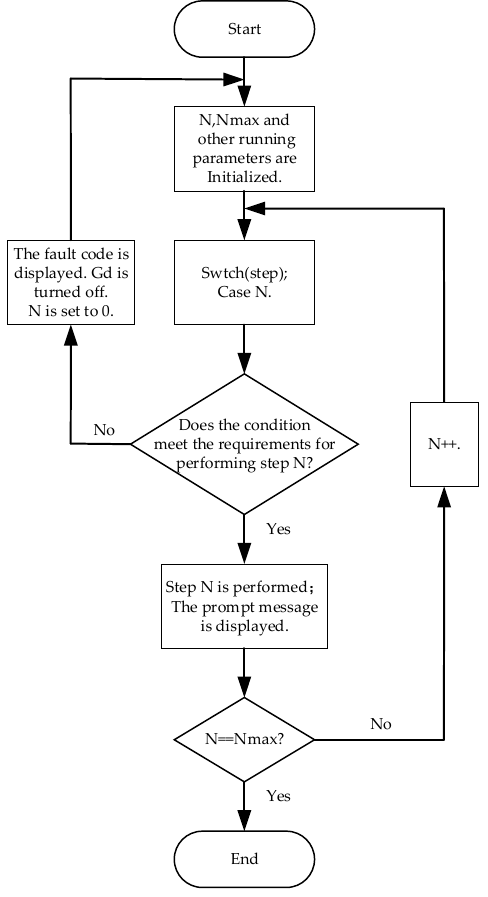
Figure 6. The control strategy of SCDBS.